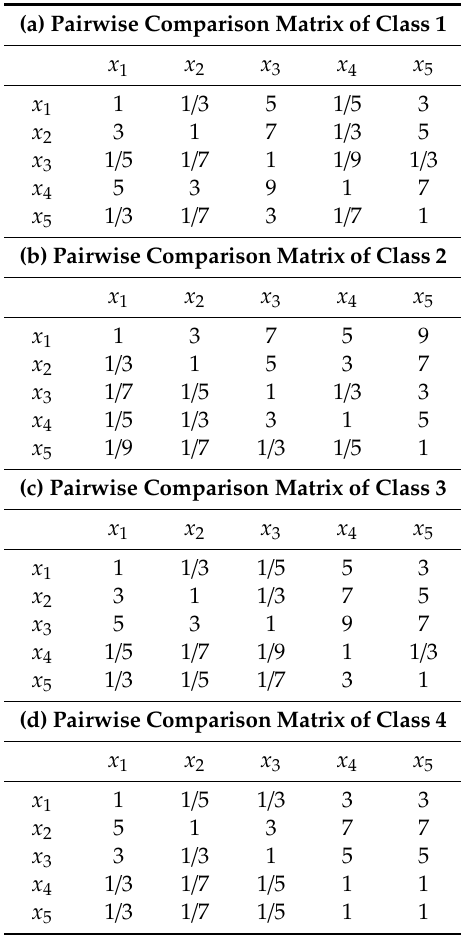
Table 10. Pairwise comparison matrix of each class.